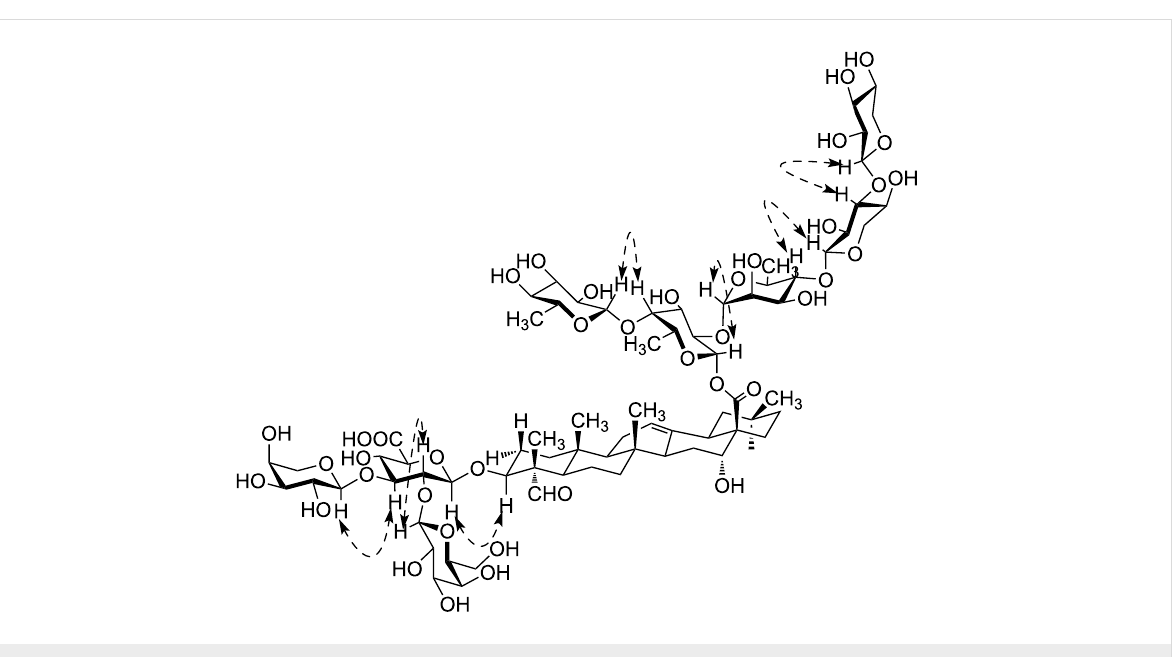
Figure 3: Key ROESY (dashed line) correlations for compound 1